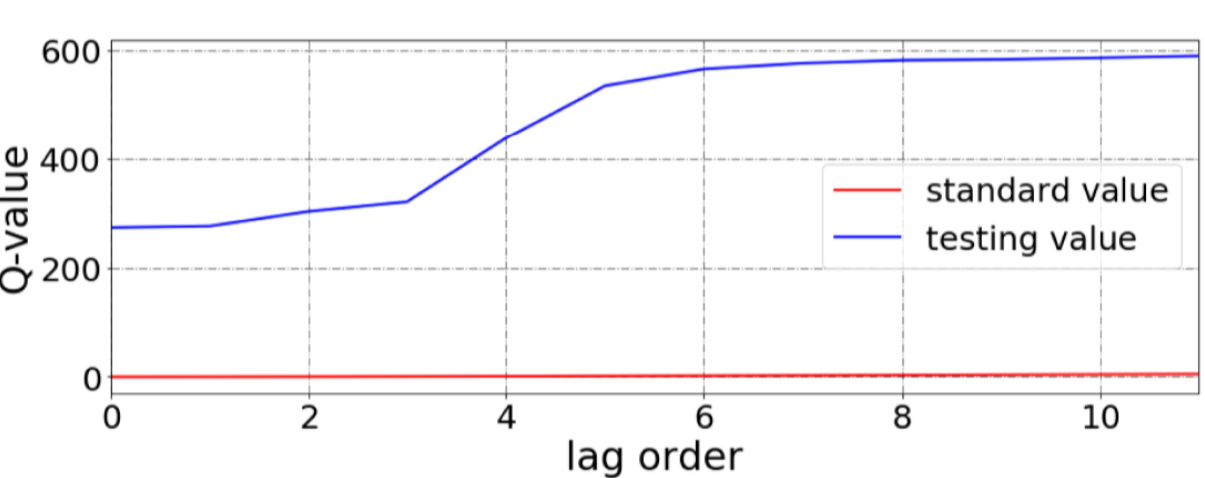
The measures were also calculated and listed as well. Table 4 is the related